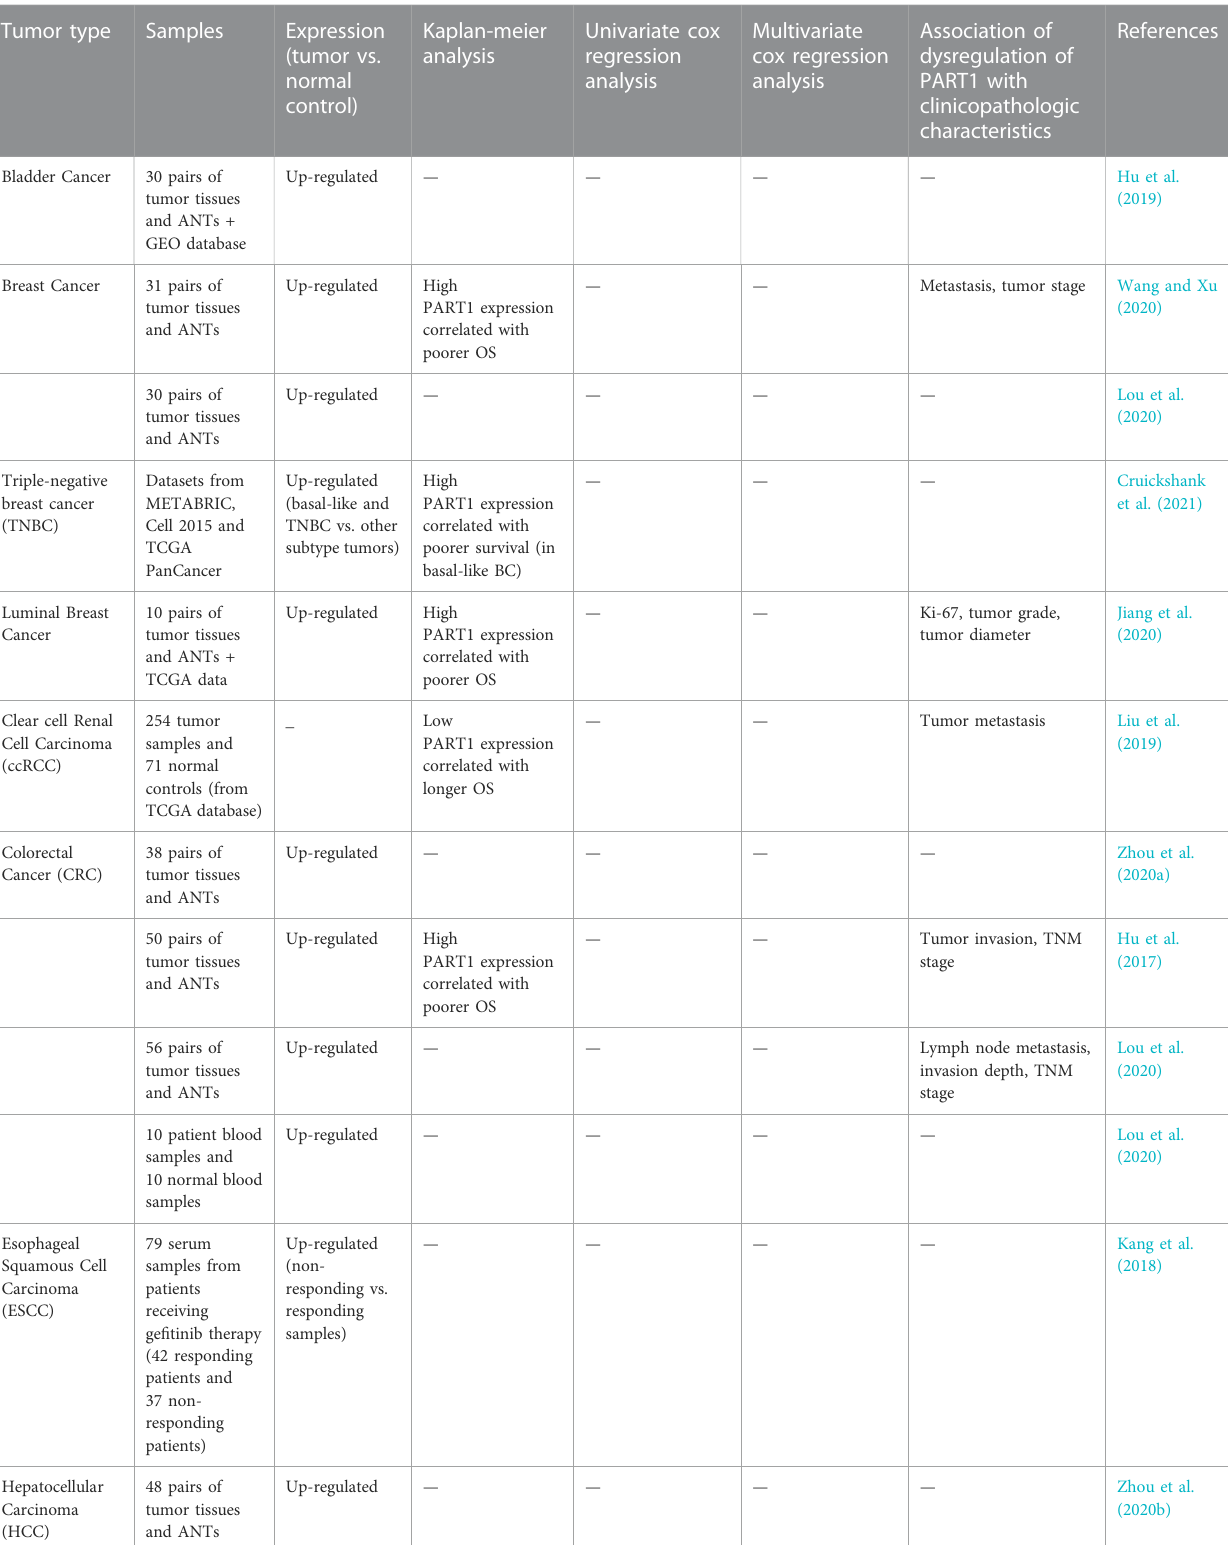
TABLE 4 Function of PART1 up-regulation in the development of malignancy on the basis of studies in clinical samples (ANTs: adjacent normal tissues, TCGA: the cancer genome atlas, METABRIC: molecular taxonomy of breast cancer international consortium, GEPIA: gene expression pro fi ling interactive analysis, GEO: gene expression omnibus, GTEx: genotype – tissue expression, ENCORI: encyclopedia of RNA interaction, GBM: high-grade glioma, LGG: low-grade glioma, ER: early recurrence, BCLC: Barcelona clinic liver cancer, OS: overall survival, DFS: disease-free survival, FIGO: international federation of gynecology and obstetrics, TNM: tumor-node-metastasis, T stage: tumor stage, T classi fi cation: tumor classi fi